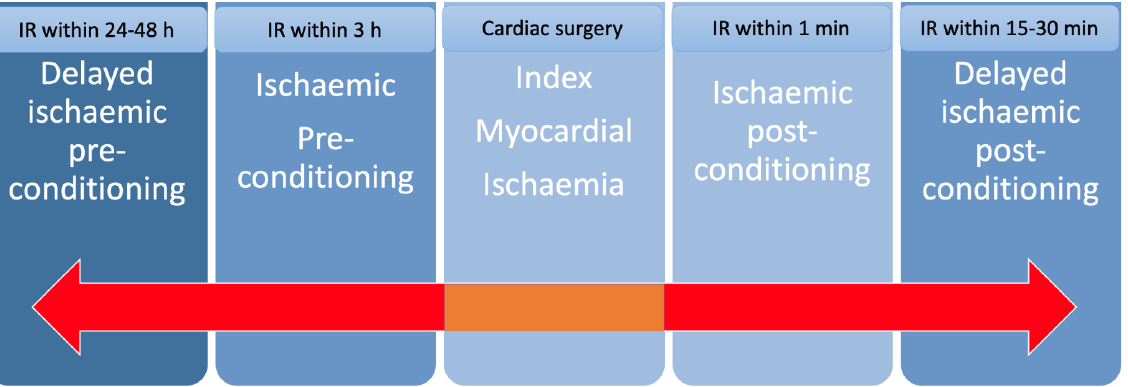
Figure 2. Types of ischaemic conditioning and relation to surgery according to ref. [17]. Legend: IR — ischaemia reperfusion.